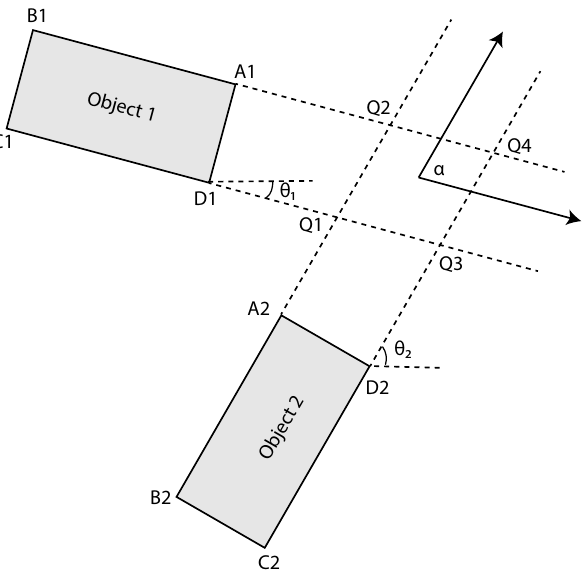
Figure 4. Illustration of intersection point between two moving objects. A1, B1, C1, D1, A2, B2, C2, and D2 represent corner point coordinates of two objects. Q1, Q2, Q3, and Q4 represent intersection coordinates. α represents collision angle between two